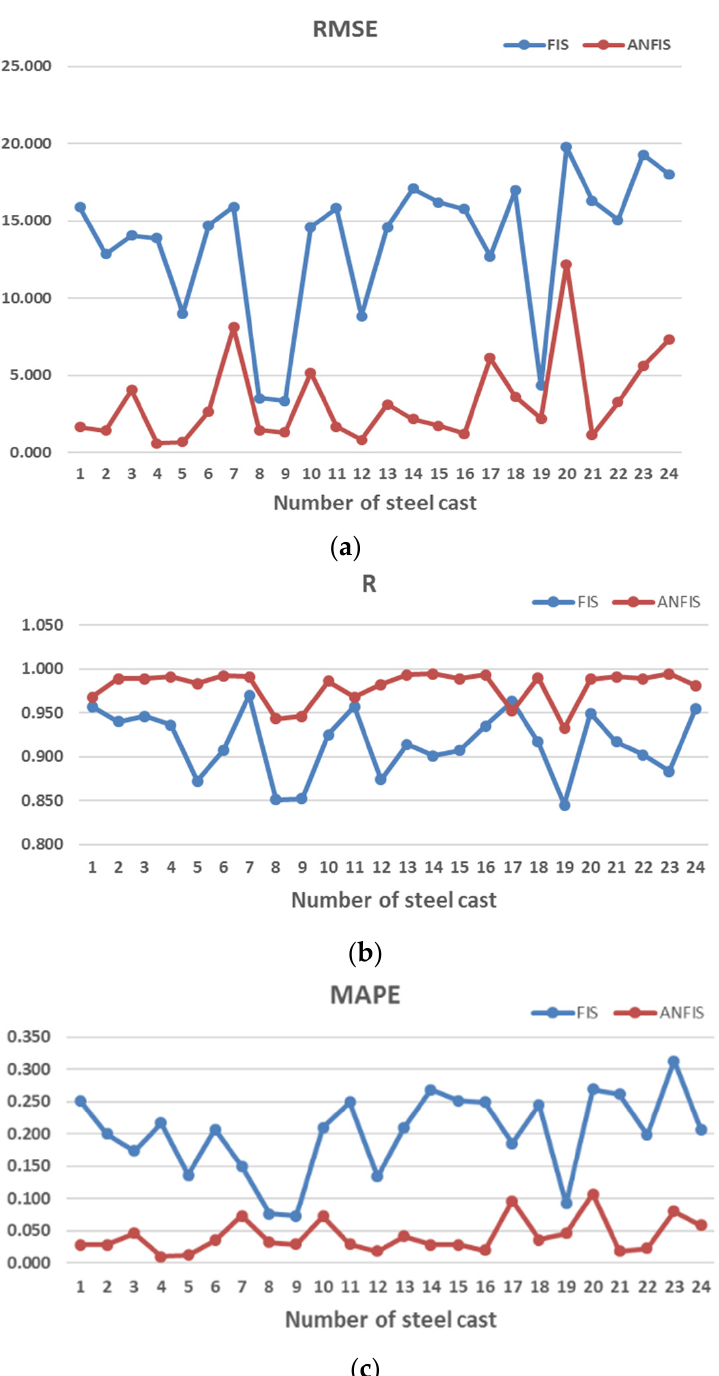
Figure 7. Measuring the diagnostic accuracy for all steel casts with valve erosion: ( a ) Comparing